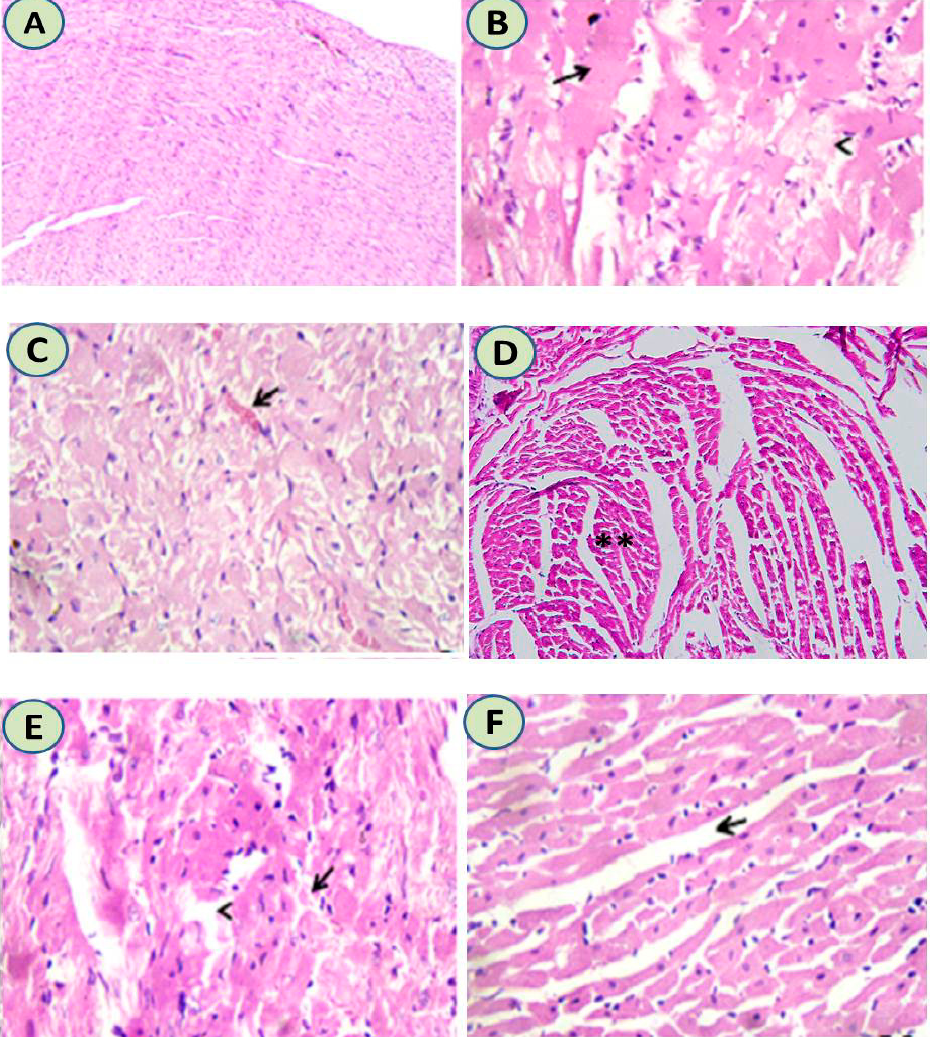
Figure 2. ( A ) The heart tissue of the control group was normal in structure (H&EX200). ( B ) Azithromycin-treated group showed hyaline degeneration associated with pyknotic nuclei and myolysis (H&EX400). ( C ) Etoricoxib-treated group showed intramuscular edema and congested capillaries, and partial necrotic changes were evident in the myocardium. (H&EX400) ( D ) Ascorbic acid-treated group showed normal cardiac tissues with normal intramuscular muscles (**) with normal sized nuclei (H&EX200). ( E ) Etoricoxib-azithromycin treated group showed hyalinized or necrotic myocardial muscle fibers alongside a few scattered lymphocytes among necrotic muscle fiber (H&EX400). ( F ) Upon administration of ascorbic acid with azithromycin and etoricoxib, it was shown that the majority of muscle fibers nearly returned to their normal state with mild edema and few scattered lymphocytes